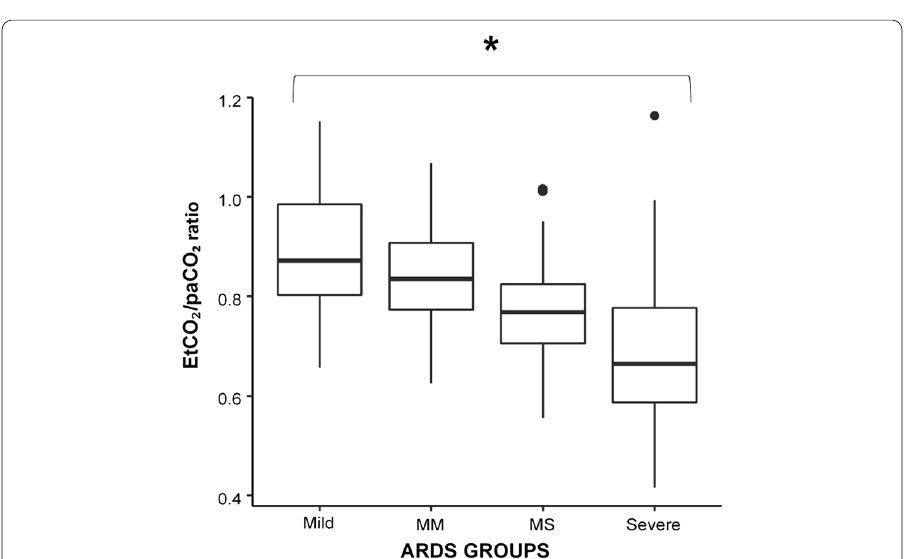
Fig. 1 Panel A: P ET CO 2 /PaCO 2 ratio among acute respiratory distress syndrome (ARDS) groups divided in Severe, Moderate–Severe (MS), Moderate–Mild (MM) and Mild groups at 5 cmH 2 O of positive end-expiratory pressure (PEEP). * p < 0.001, Mann–Whitney